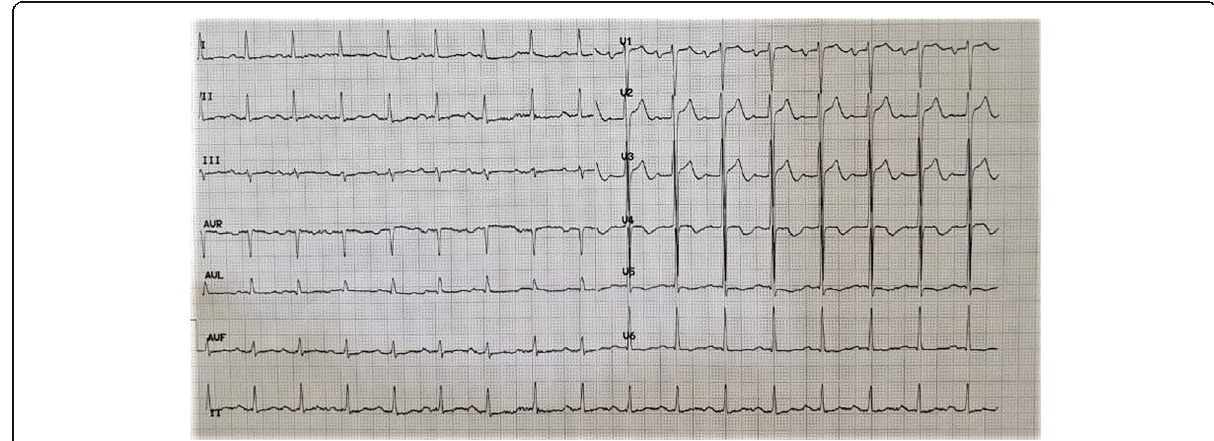
Fig. 4 Electrocardiography re-evaluation on the third day showed biphasic T waves in lead V2 and